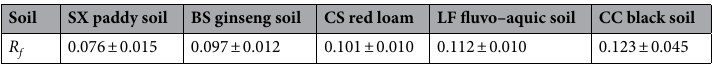
Table 6. Values of propaquizafop in five soil plates (n = 3).